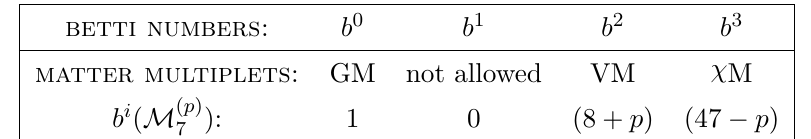
2 manifold and the